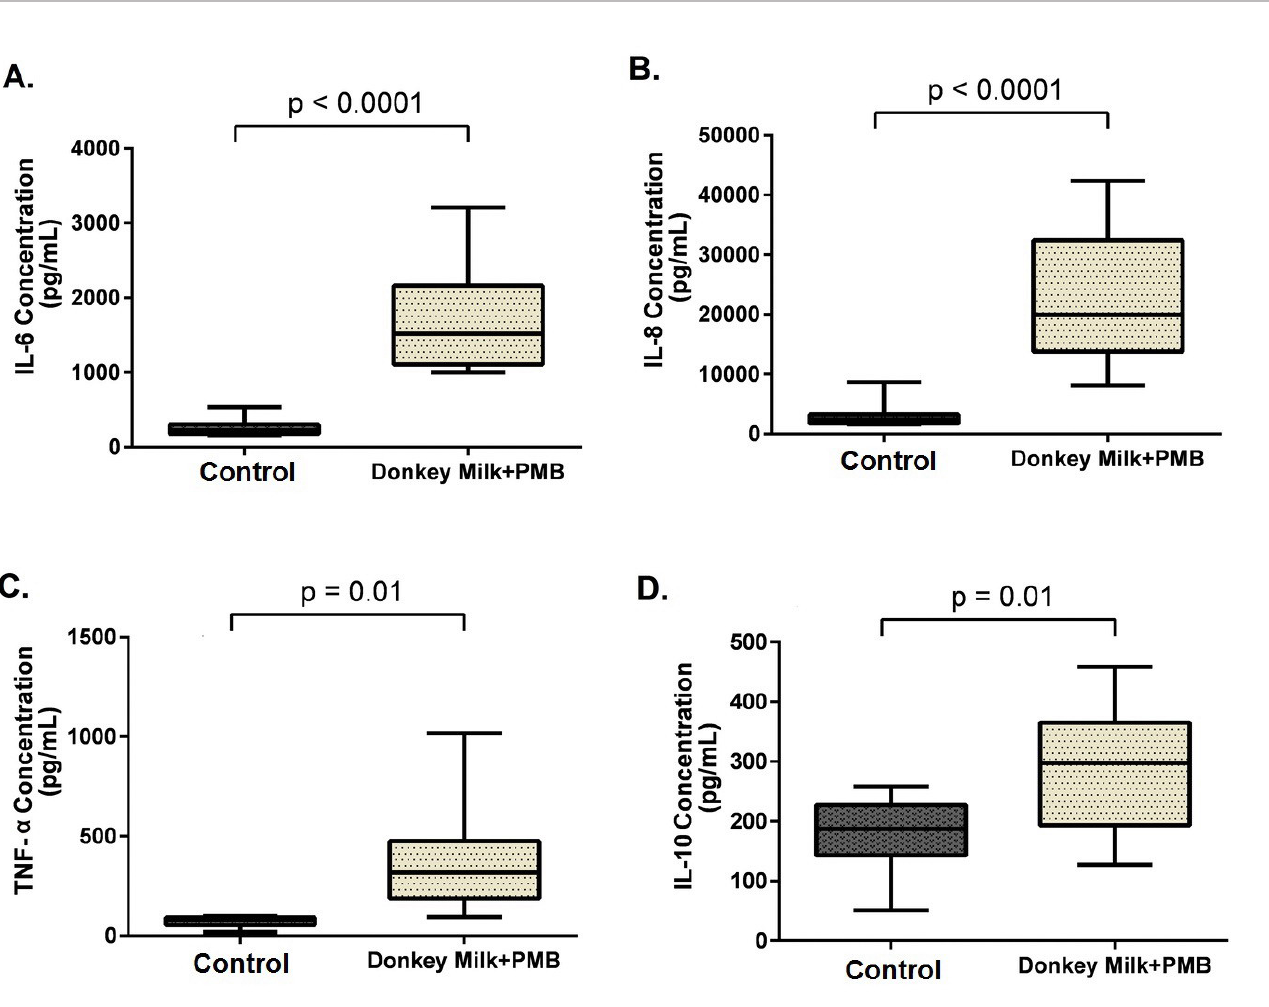
FIGURE 2 - Cytokine levels from PBMCs with or without treated by donkey’s milk in study subjects (by ELISA). (A) IL-6 levels, (B) IL-8 levels, (C) TNF- α levels, and (D) IL-10 levels from subjects with or without treatment. (A-D) Horizontal bars, boxes and whiskers represent median, 25/75% quartiles and range and the lines show the most extreme observations. Statistical comparisons made by Wilcoxon matched-pairs test, differences were considered statistically significant for